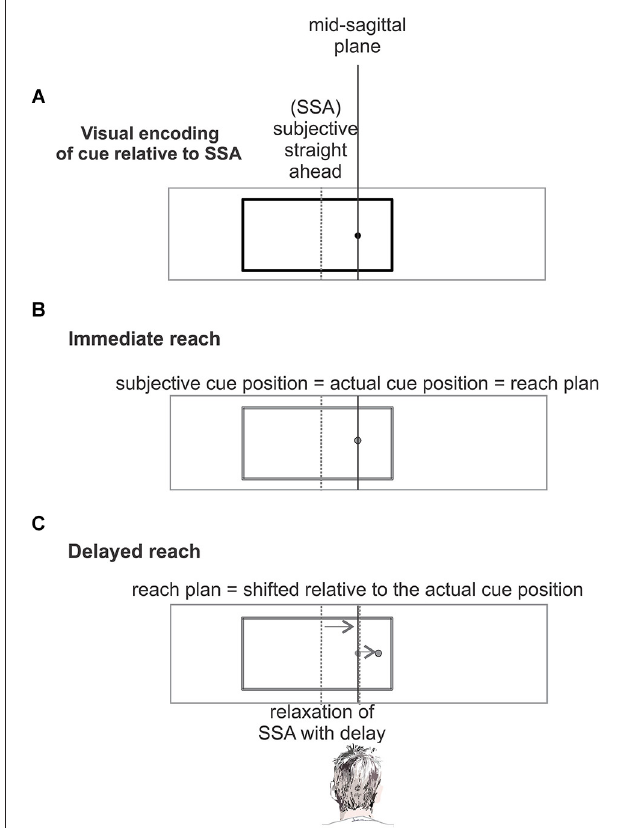
FIGURE 1 | The biased-midline hypothesis (Dassonville and Bala, 2004b). (A) An off-center visual frame (black) shifts the subjective straight ahead (SSA, gray dashed line) in the direction of the frame. The location of a simultaneously presented cue is encoded in this distorted egocentric reference frame centered on the SSA. (B) In an immediate response task, after presentation of the cue and frame (panel A ) the corresponding movement plan will be encoded and executed in the same shifted frame of reference and no mislocalization occurs. (C) In a delayed-response task, presentation of the cue and frame (panel A ) is followed by a memory period. During the memory period, i.e., before movement execution, the temporarily biased SSA drifts back to the objective straight-ahead. The movement which was planned relative to the temporally biased egocentric reference will be executed relative to the original reference after relaxation of SSA back to objective straight-ahead and will show a localization error opposite to the direction of the frame